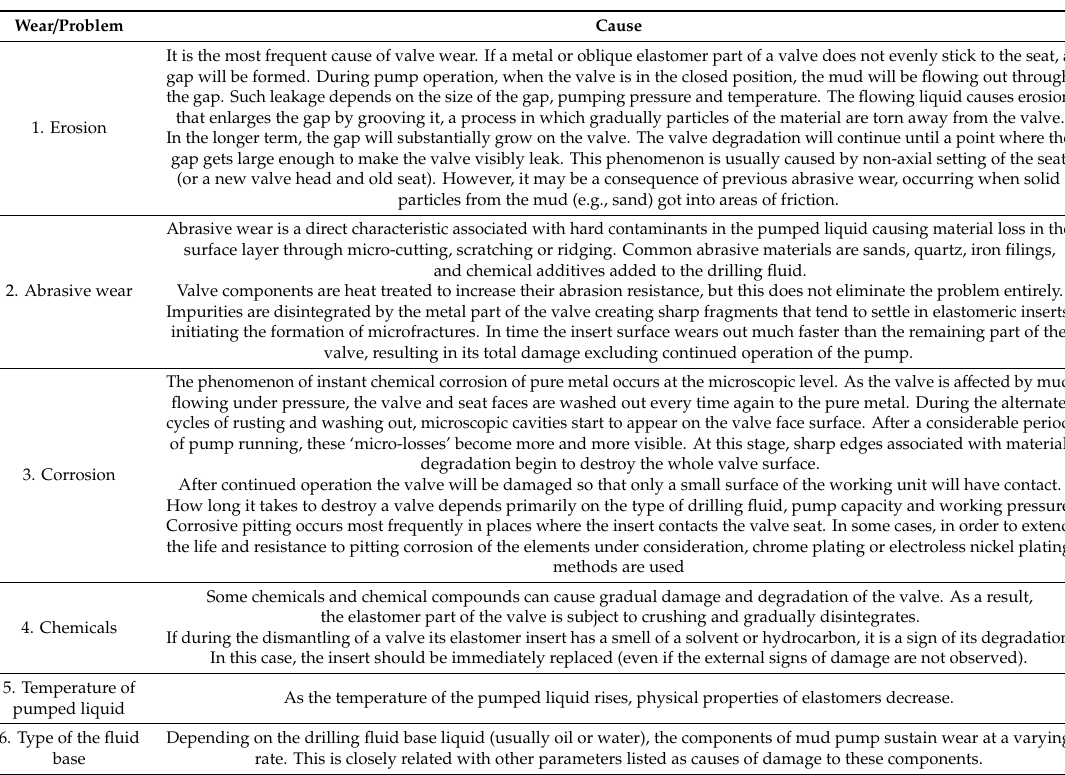
Table 1. Main causes of mud pump component failures